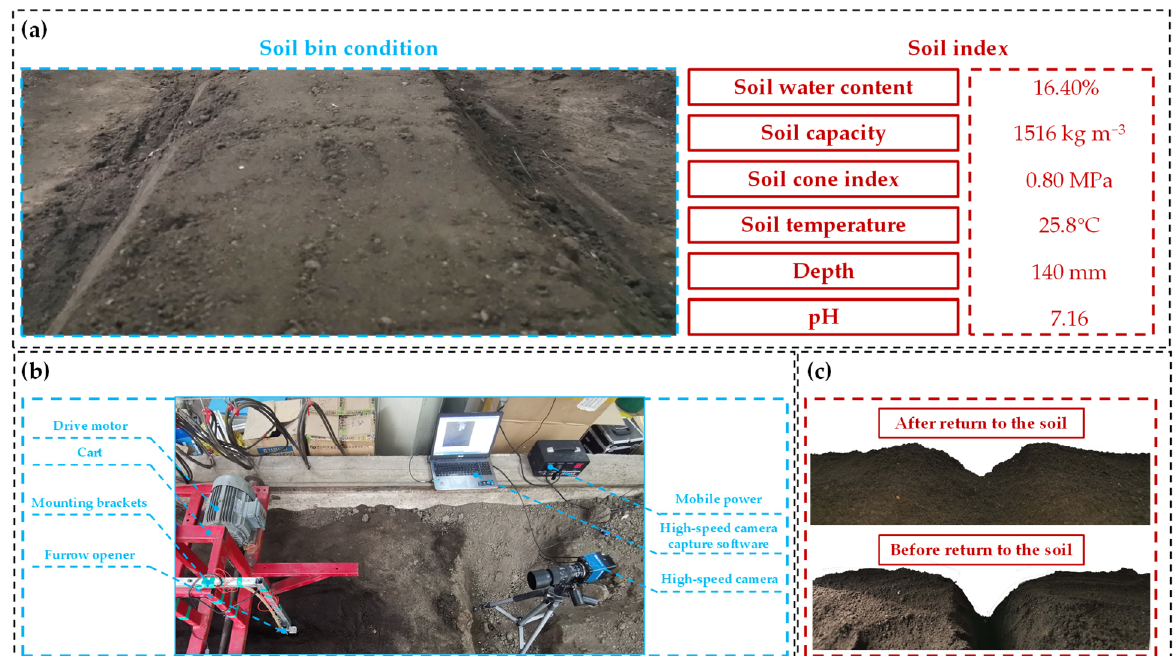
Figure 6. Soil bin test process and equipment. ( a ) Soil conditions and indicators of the indoor soil bin test. ( b ) Relevant equipment related to the indoor soil bin test. ( c ) The extraction process and results of soil furrow contour parameters.